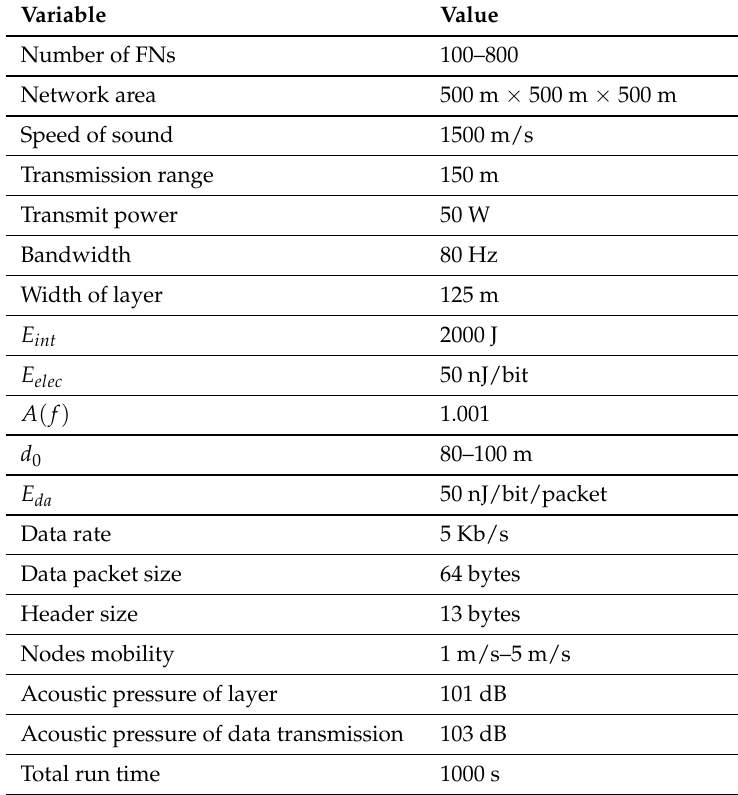
Table 1. The values of parameters selected for the